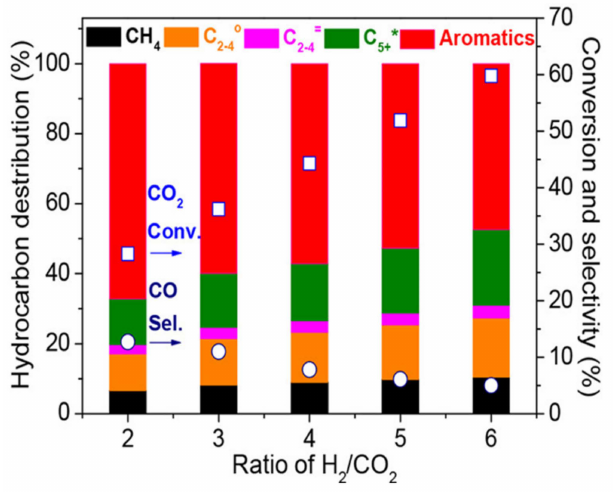
Figure 17. The effect of the H 2 /CO 2 ratio on the catalytic performance over ZnFeO x -4.25Na/S- HZSM-5 catalysts. Reaction conditions: 320 ◦ C, 3.0 MPa, GHSV = 4000 mL · g cat–1 · h –1 . C 5+ * means C 5+ products except for aromatics. Reprinted with permission from Cui et al. [60]. Copyright (2019) American Chemical